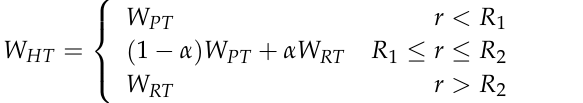
Figure 6. Typhoon tracks for each category during the period 1978–2017. ( a – i ) are corresponding to C1–C9. 2.6. Metrics for Evaluation of Model Performance Mean absolute error ( MAE ), root-mean-square error ( RMSE ), mean absolute percentage error ( MAPE ), and skill were used as criteria to evaluate the model performance for hindcasts of SWHs. It must be noted that the MAPE can only be used when there are no zero values among observations. A skill value of 1 means a perfect performance. A skill value ranging between 0.65 and 1.0 indicates excellent performance. A very good performance is in the range of 0.5 to 0.65; a good performance is in the range of 0.2 to 0.5, and a skill value less than 0.2 represents a poor performance [56]. The formulas for MAE , RMSE , MAPE , and skill are given as: 1 1 MAE